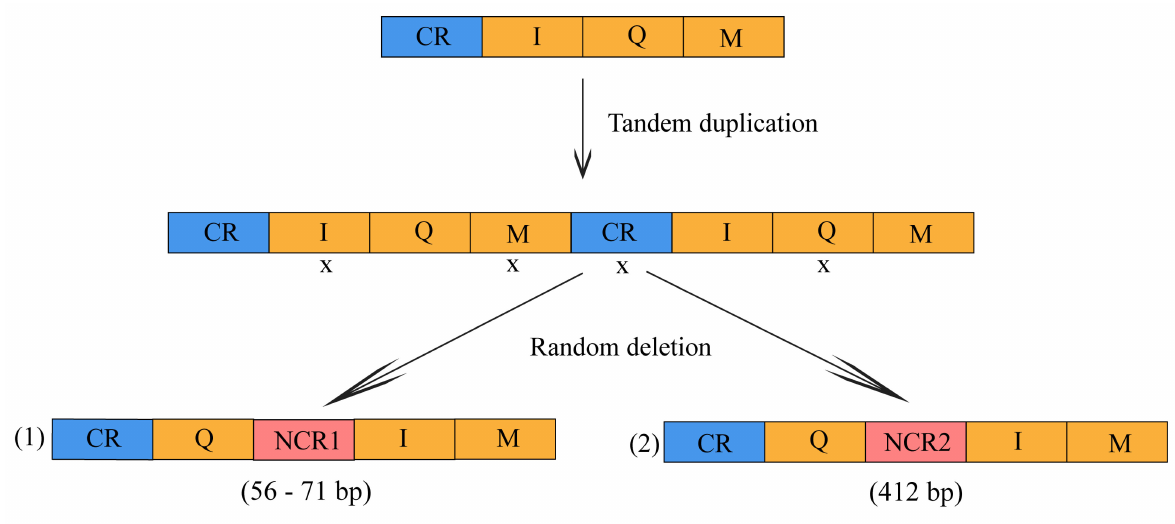
Figure 4. Gene rearrangement and locations of the generated non-coding regions between trnQ and trnI among Dynastinae species. The two non-coding regions (NCR) are colored in salmon (NCR1) and (NCR2). CR: control region; I, Q, M correspond to trnI, trnQ, trnM; ( 1 ) represent the gene rearrangement in: Chalcosoma caucasus caucasus, Dynastes hercules hercules , Oryctes nasicornis , Xylotrupes beckeri intermedius , X. g. beckeri , X. g. siamensis , X. g. sumatrensis species; and ( 2 ) represent: Megasoma elephas elephas , M. mars species gene